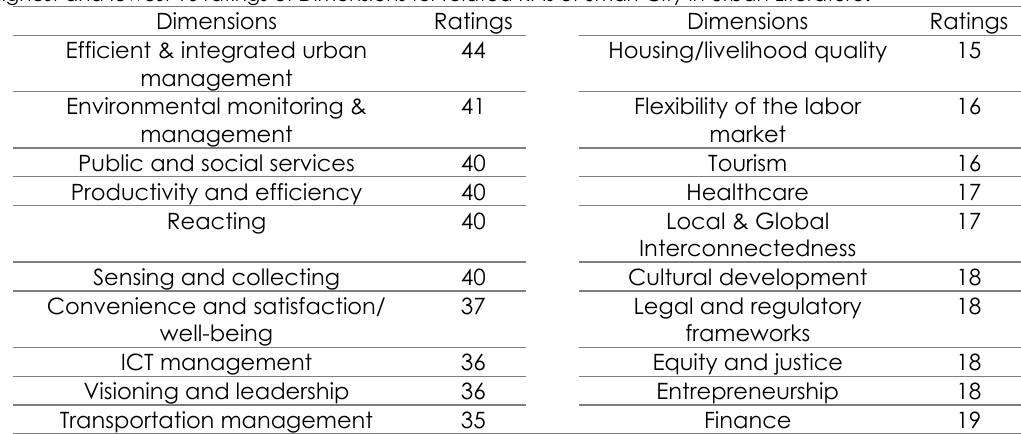
Table 7. Highest and lowest 10 ratings of Dimensions for related KPIs of Smart City in Urban Literature .